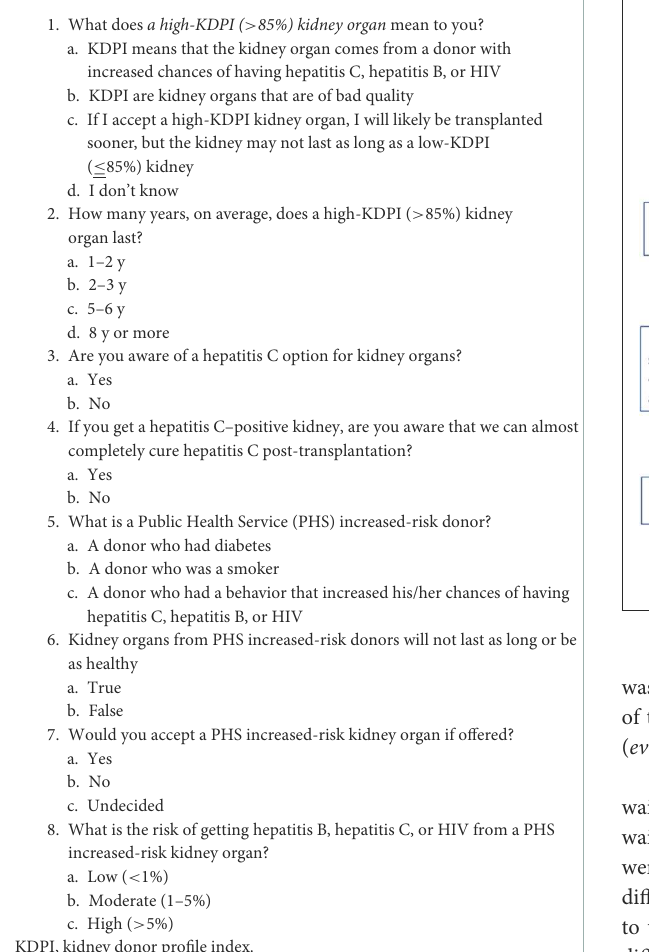
BOX 1 Questionnaire of kidney transplant candidates.